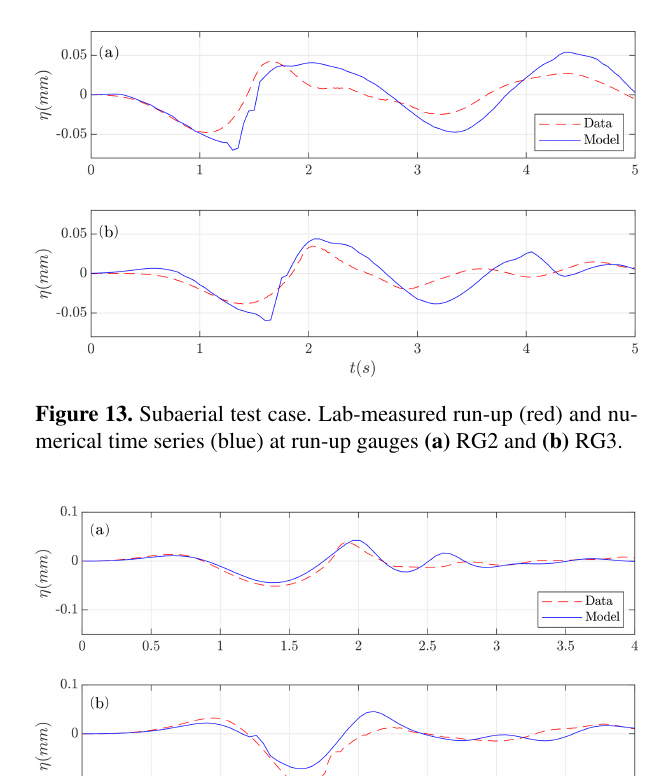
For each case, measured free-surface elevations are given for two wave gauges placed at (x,y) = ( 1 . 83 , 0 ) (in m) and (x,y) = ( 1 . 2446 , 0 . 635 ) , where x is the distance to the initial coastline and y is the distance to the central cross section (see location in Fig. 11, lower panel). Also measured run-up for each case is given at run-up gauges 2 and 3 in Fig. 11, lower panel, lying on the slope at a distance 0.305 and 0.611 m from the central cross section, respectively.